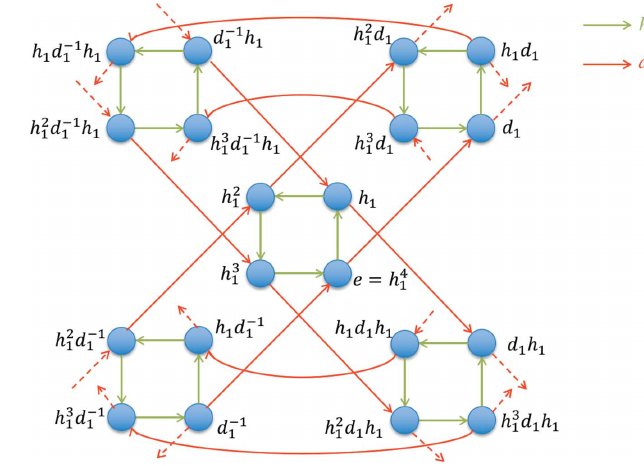
Figure 2 A part of the Cayley graph G of the crystal deformation group D with a specified set of generators { h 1 , d 1